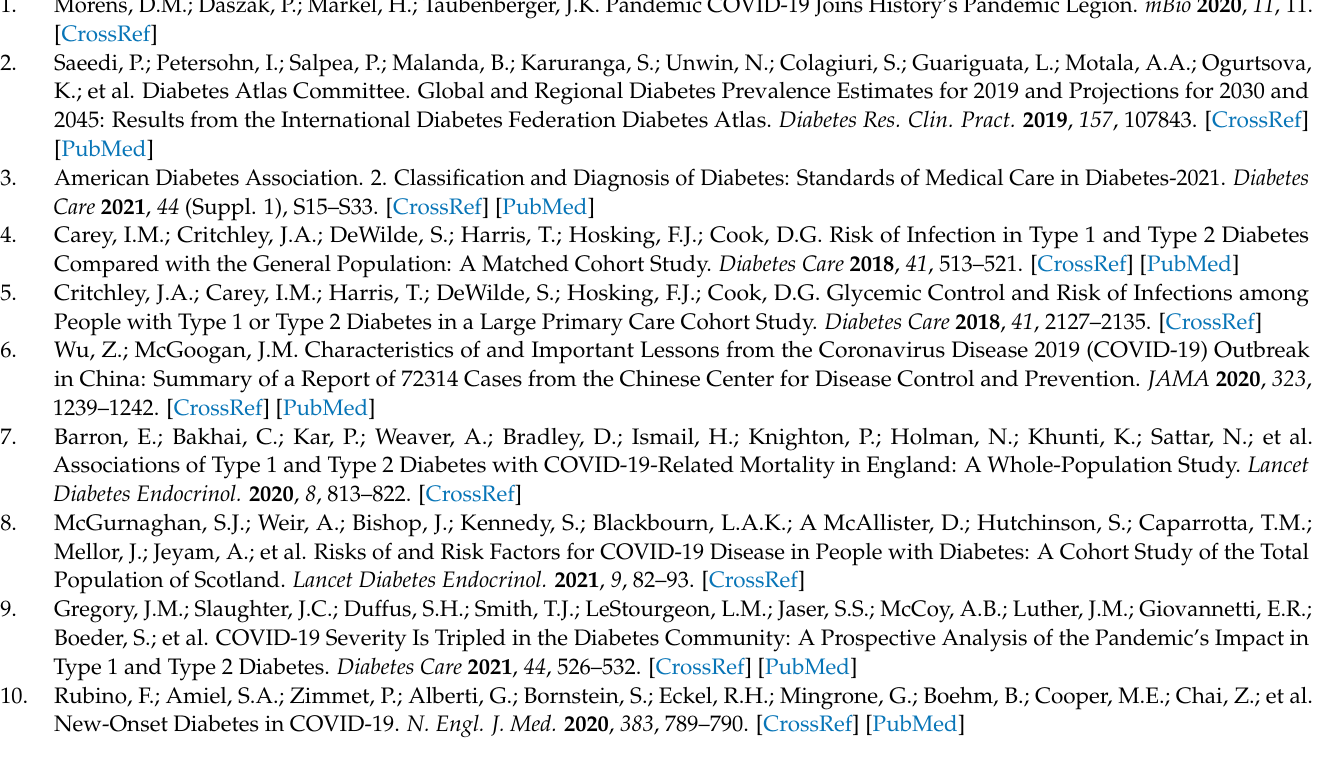
Table S3: Overview of the risk for adverse clinical outcomes of COVID-19 according to the glycemic control during